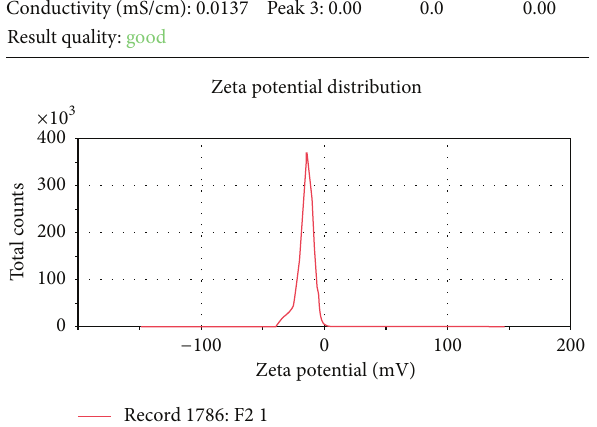
Figure 4: Zeta potential analysis of optimized formulation (F2).